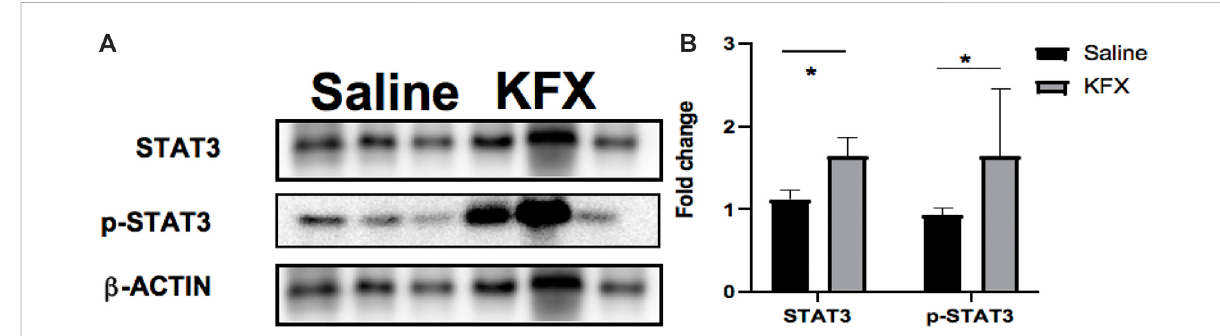
FIGURE 5 Effects of Kangfuxin on the cell proliferation and migration – related signaling pathway in vivo . (A,B) Protein levels of STAT3 signaling pathway – relatedproteins. β -actinproteinwasusedasaninternalcontrol.Dataareshownasmean±SDvalues.* p < 0.05,** p < 0.01,*** p < 0.001vs. the control group. NS, not signi fi